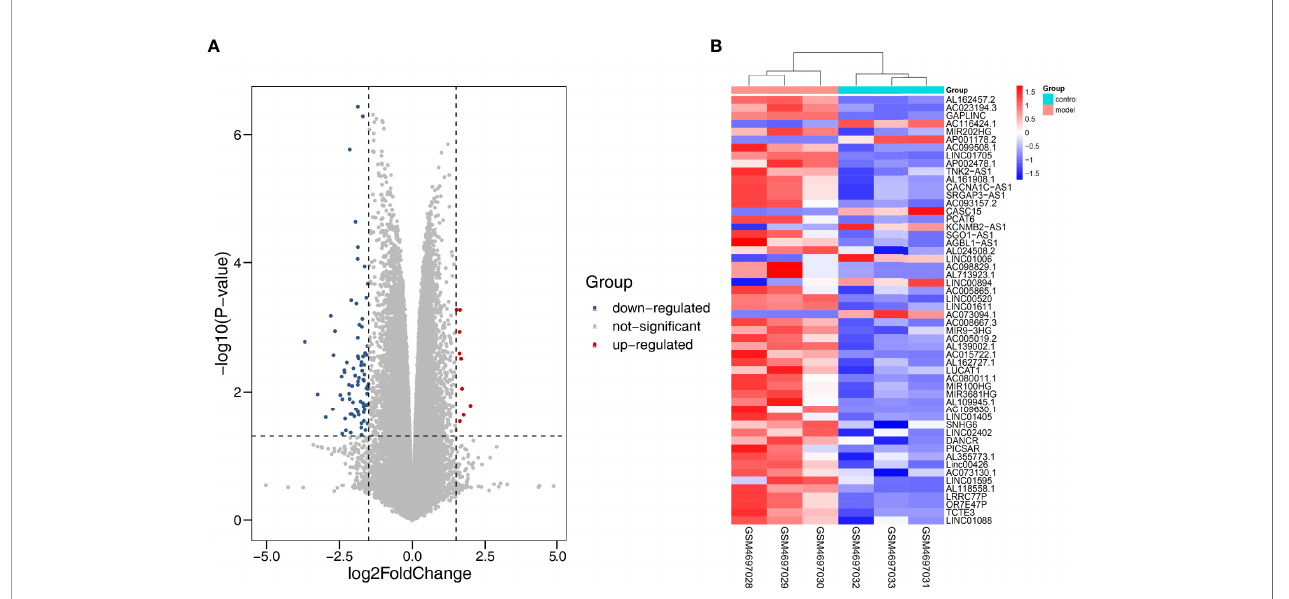
FIGURE 8 | Differentially expressed lncRNA in DN. (A) Red dots represent upregulation, blue dots represent downregulation, and gray dots represent no differential expression. (B) Red represents upregulation, and blue represents downregulation.